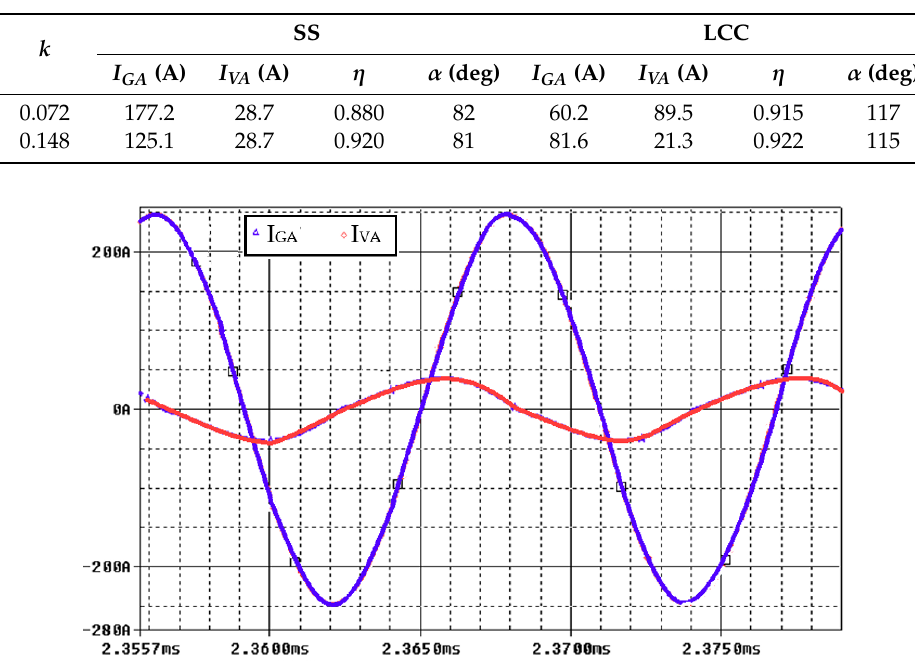
Figure 14. Waveforms of the coil currents for SS compensation.